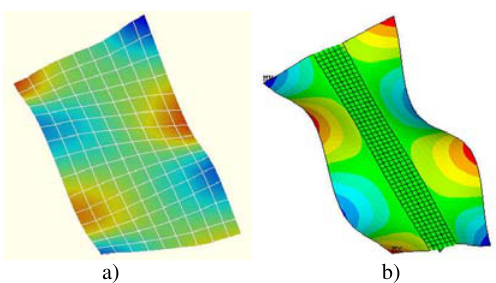
Fig 10. Mode shape for the sixth